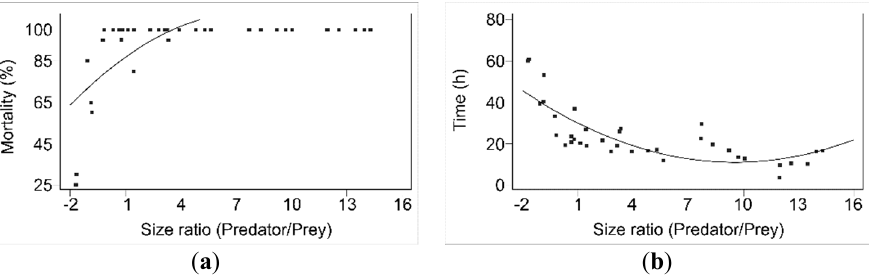
Figure A3. Relationship between mortality (%) ( a ) and survival time (h) ( b ) in the predation of Nesidiocoris tenuis by Nabis pseudoferus , depending on the size ratios between prey-predator, when N. pseudoferus was always in a lower stage class than N. tenuis . Table A1. Combinations used in cannibalism assays for N. pseudoferus and N. tenuis under laboratory conditions and without alternative prey.